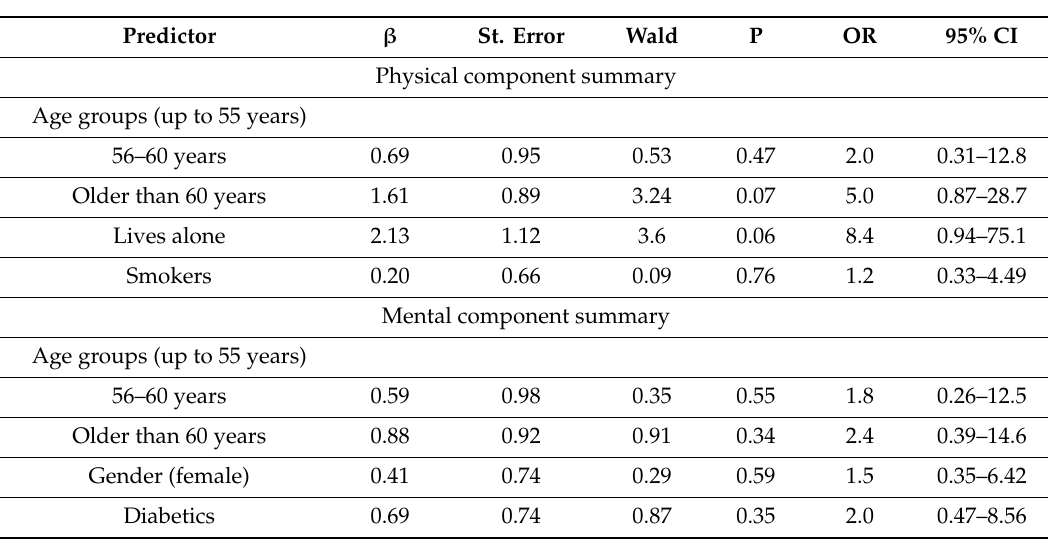
Table 5. Predicting the probability of poorer quality of life after rehabilitation (univariate regression analysis).